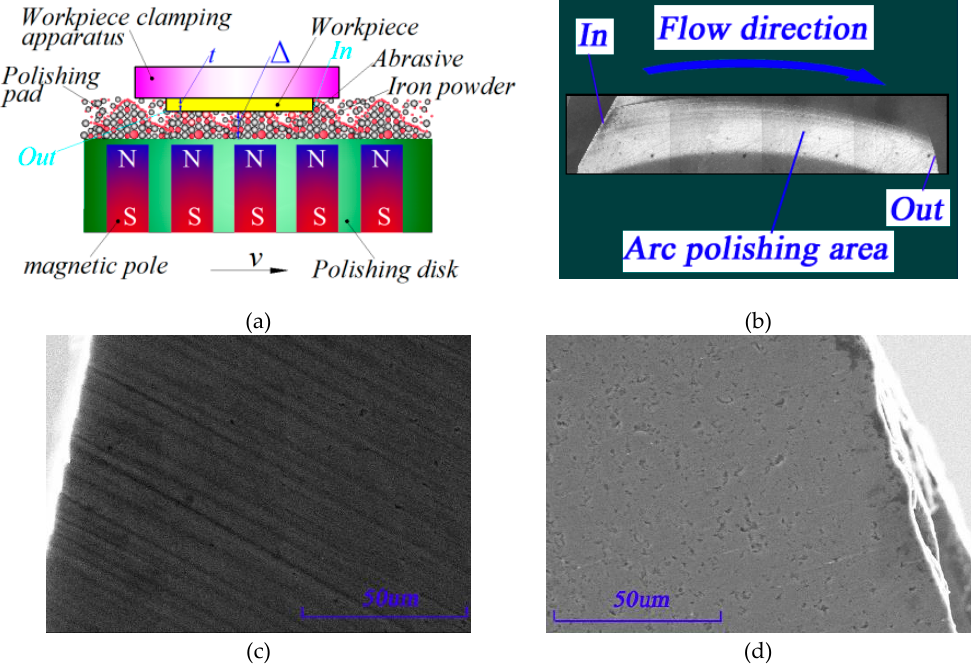
Figure 11. Scanning electron microscope (SEM) morphology of Single crystal 6H-SiC wafer polishing belt. ( a ) Schematic diagram of polishing, ( b ) schematic diagram of the polishing belt, ( c ) SEM morphology of entrance and ( d ) SEM morphology of exit.